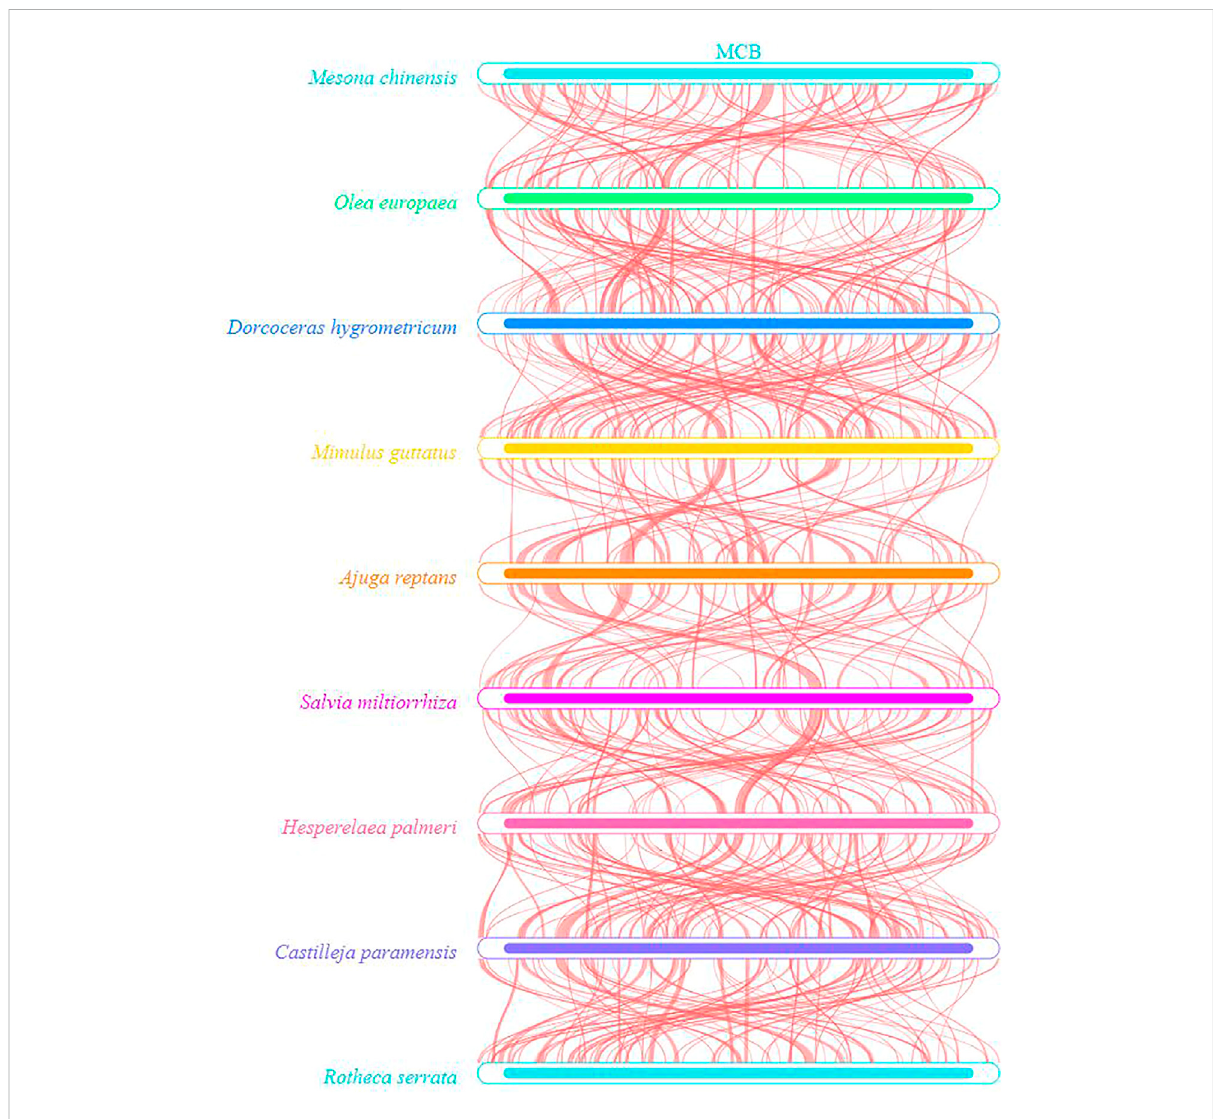
FIGURE 6 Collinearity analysis of the mitochondrial